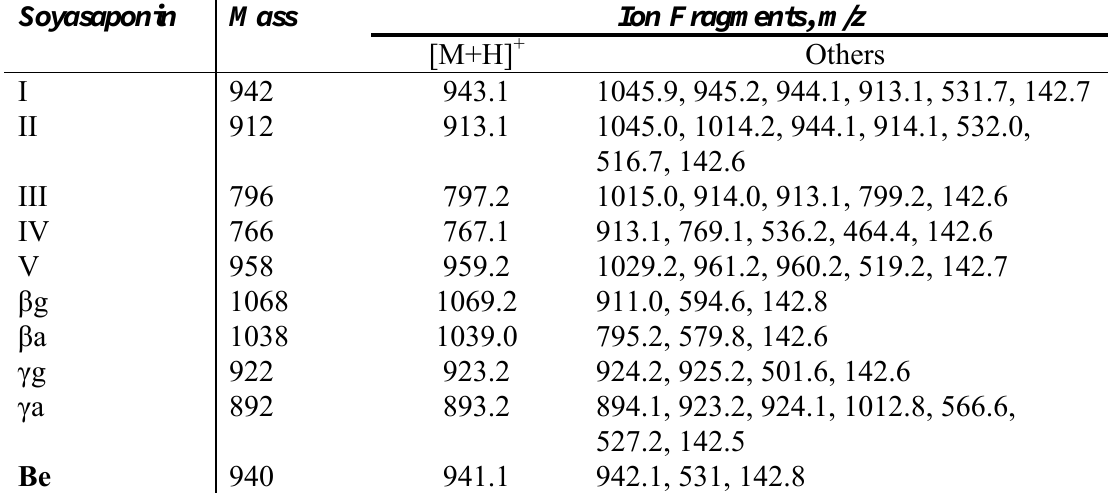
Table 4. Selective group B soyasaponins ion fragments separated and analyzed by LC-MS [19].